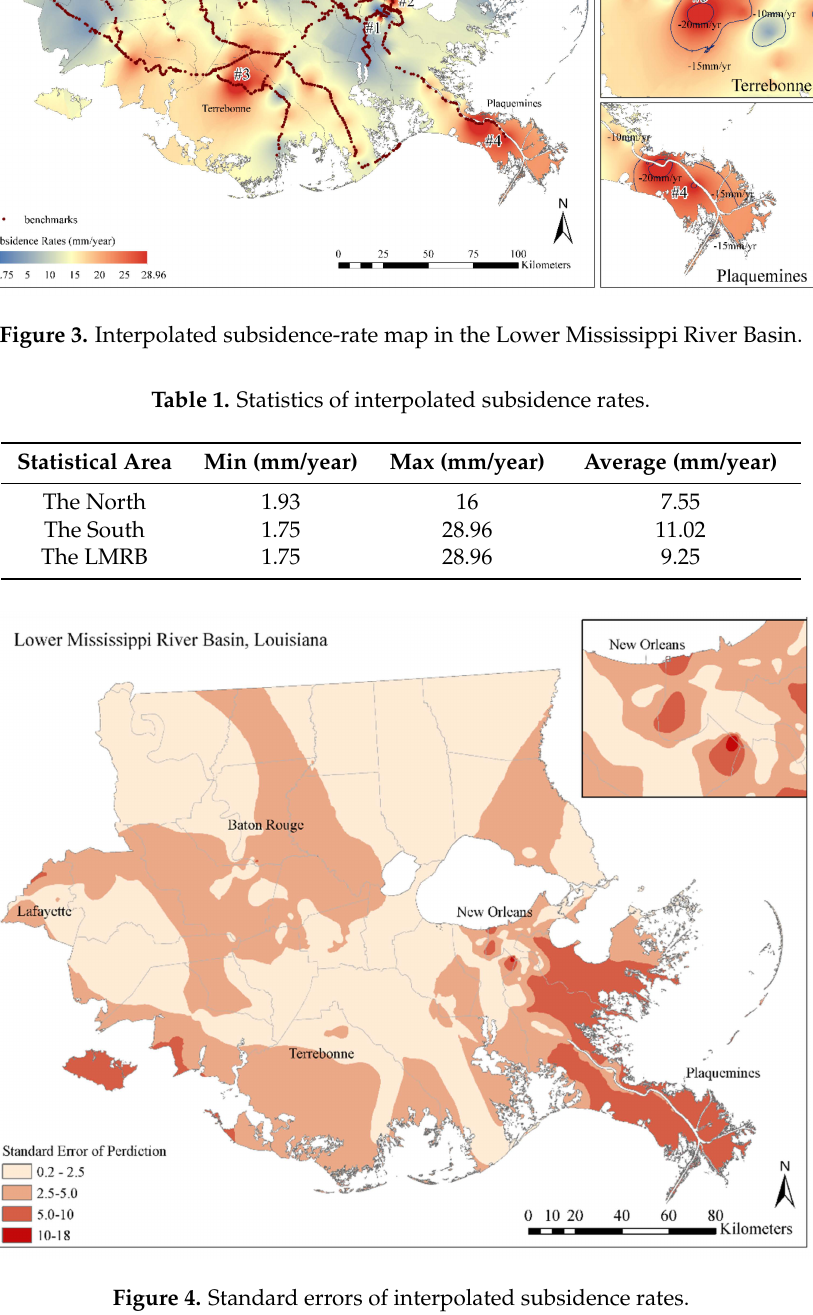
Figure 4. Standard errors of interpolated subsidence